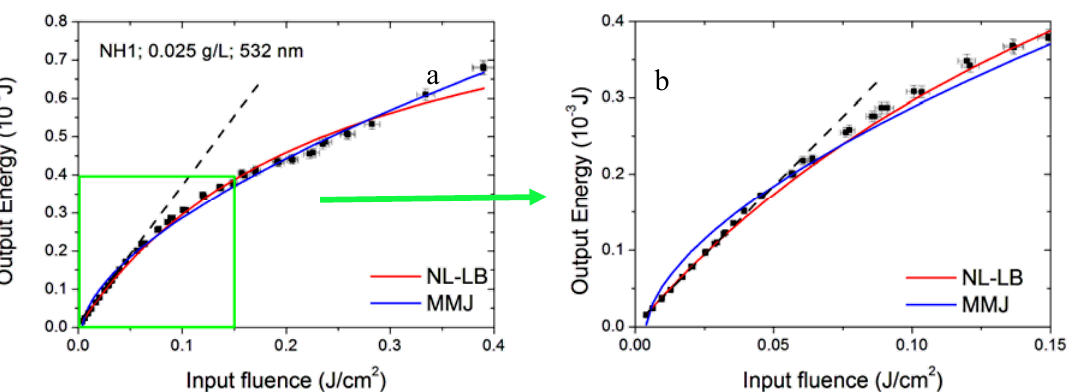
Figure 14. Fitting of the NH1 sample for the 532 nm laser wavelength and 0.025 g / L concentration. The plot ( b ) is an enlargement of the first experimental points on the ( a ) plot. The dashed black line shown in both plots is a visual reference for the linear regime.